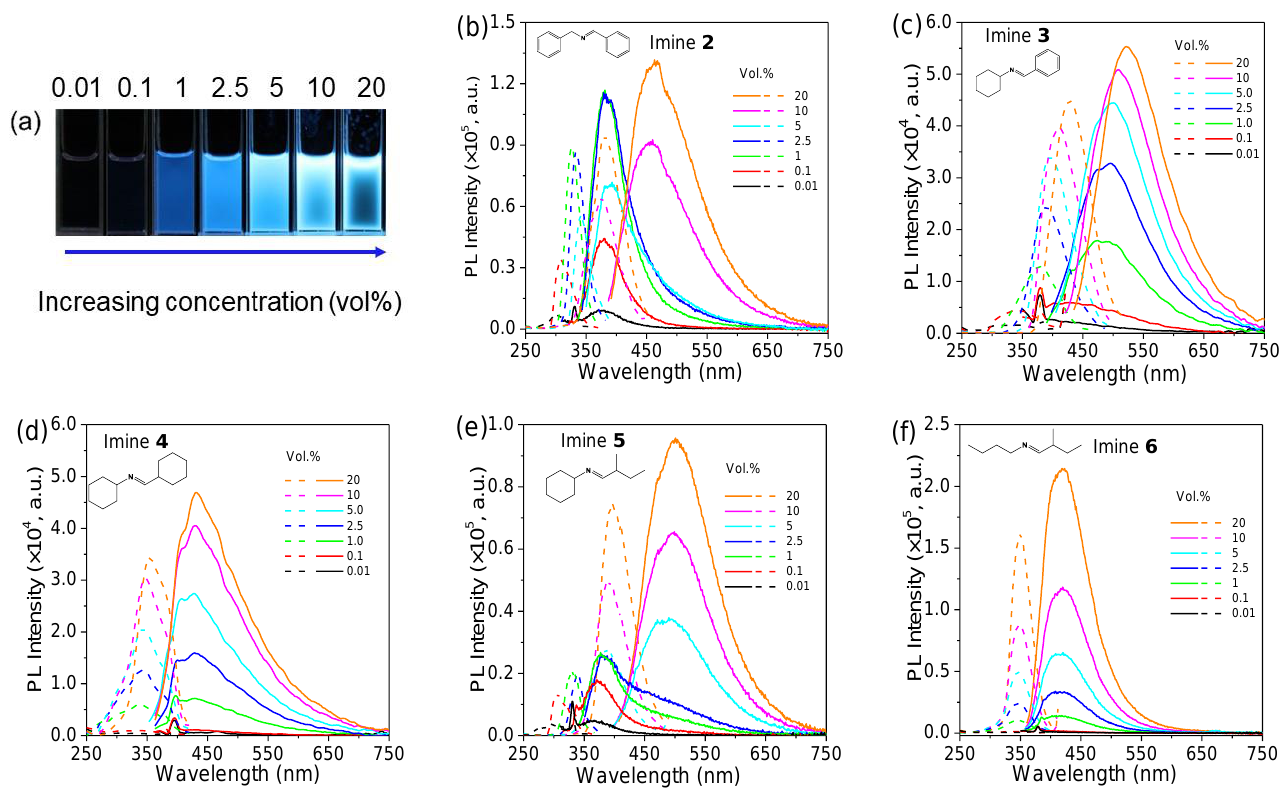
Figure 3. ( a ) Photographs of imine 6 ethanol solutions with different concentrations under 365 nm UV light (from left to right, Vol.% = 0.01%, 0.1%, 1.0%, 2.5%, 5%, 10%, 20%). ( b – f ) Fluorescence excitation spectra (dashed line) and emission spectra (solid line) of imines 2 – 6 ethanol solutions with different concentrations. Table 1. Emission wavelengths and quantum yields of imines 2 – 6 . Solution (0.1 Imine No.